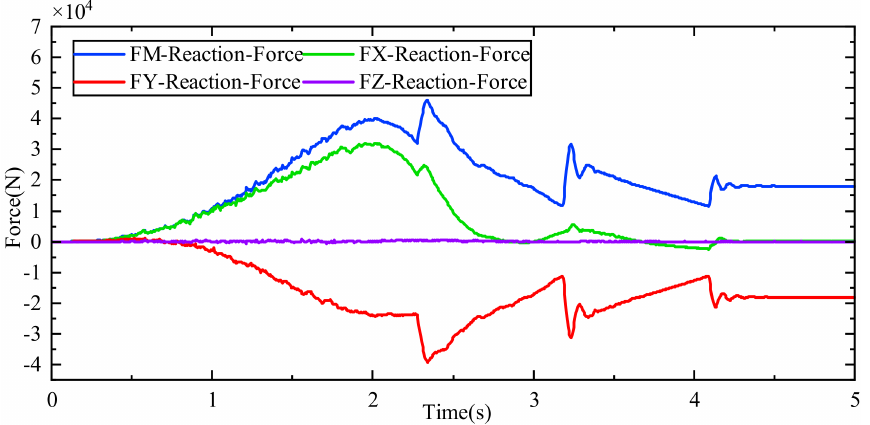
Figure 6. Graph of the force on the